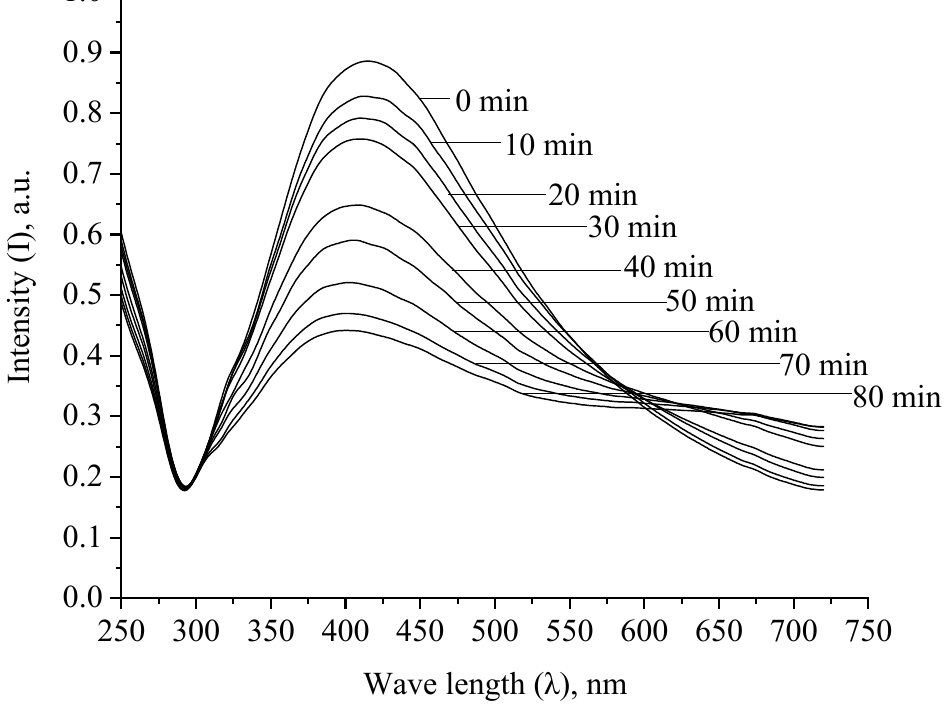
Figure 13. Absorption spectra of a mixture of Ag NPs and an oxidizer in the ratio Ag:H 2 O 2 = 1:1.